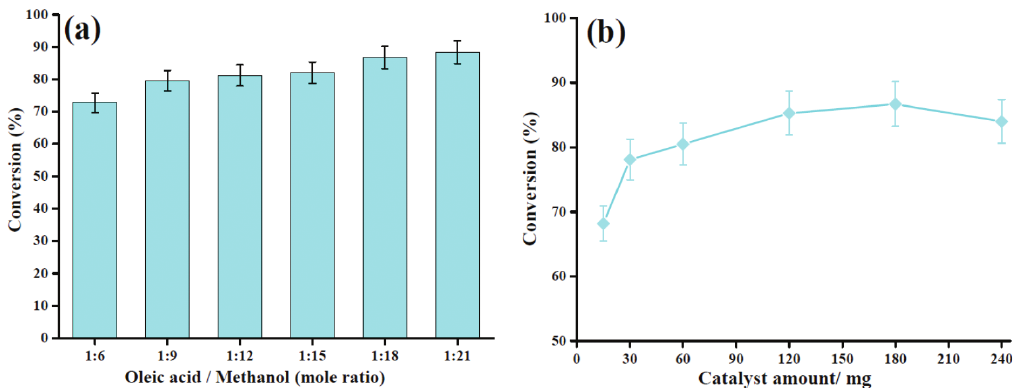
Figure 6: Effect of (a) oleic acid to methanol molar ratio (catalyst amount: 180 mg, reaction temperature: 160°C, and reaction time: 3.0 h) and (b) catalyst amount on esterification of oleic acid (molar ratio of oleic acid to methanol: 1:18, reaction temperature: 160°C, and reaction time: 3.0